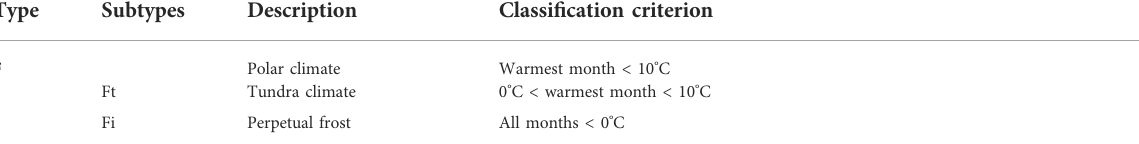
TABLE 1 ( Continued ) The criteria used for the Köppen-Trewartha climate classi fi cation system. P month and P ann are the monthly and annual precipitation (units: mm), respectively. P min , P min_winter , and P min_summer are the months with minimum precipitation (units: mm) during the winter and summerseasons.P max ,P max_winter ,andP max_summer arethemonthswithmaximumprecipitation(units:mm)duringthewinterandsummerseasons.The aridity threshold is de fi ned as 10 × (T ann – 10)+3P, T ann is the average annual temperature (units: ° C), and P is the percentage of the total